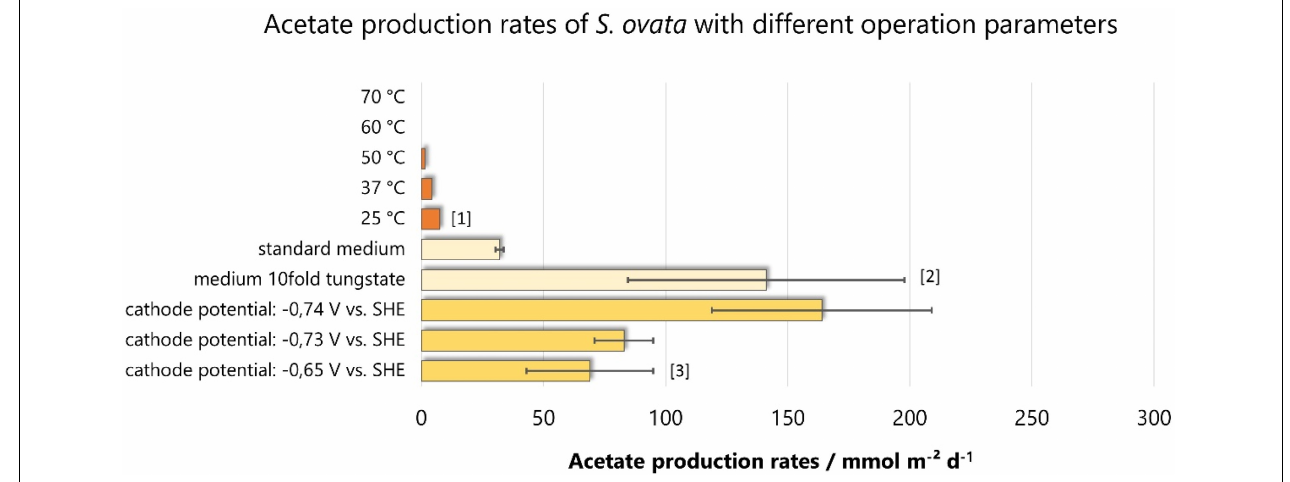
FIGURE 5 | Acetate production rates among different operation parameters with S. ovata. Bars of the same color are derived from the same studies: [1]: (Faraghiparapari and Zengler, 2017), [2]: (Ammam et al., 2016), [3]: (Giddings et al., 2015). On that basis, the same color results are directly comparable, as other parameters (electrode material, reactor setup, Sporomusa strain, etc.) are